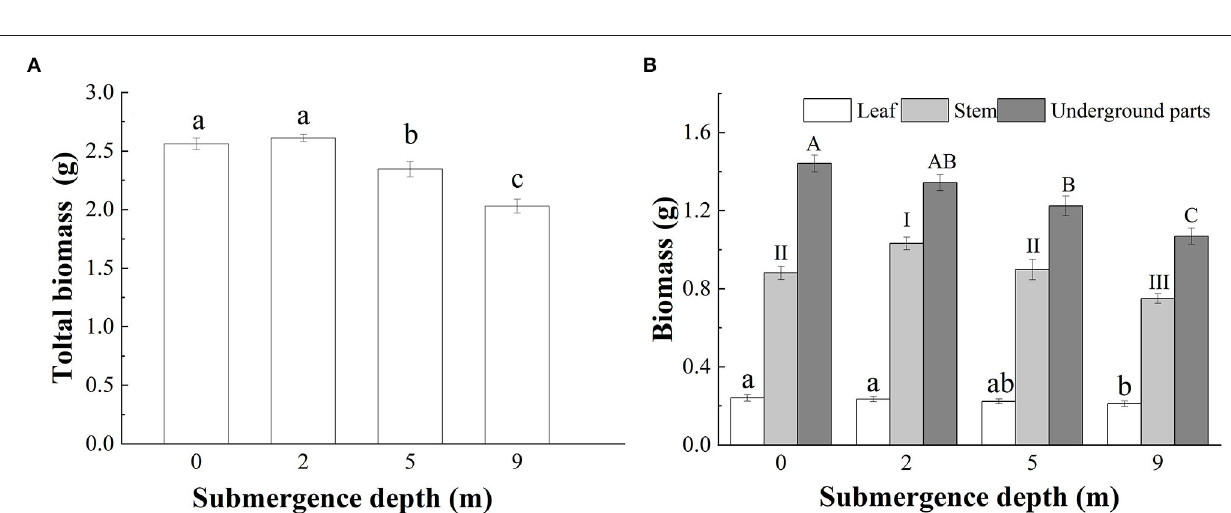
Frontiers in Plant Science |